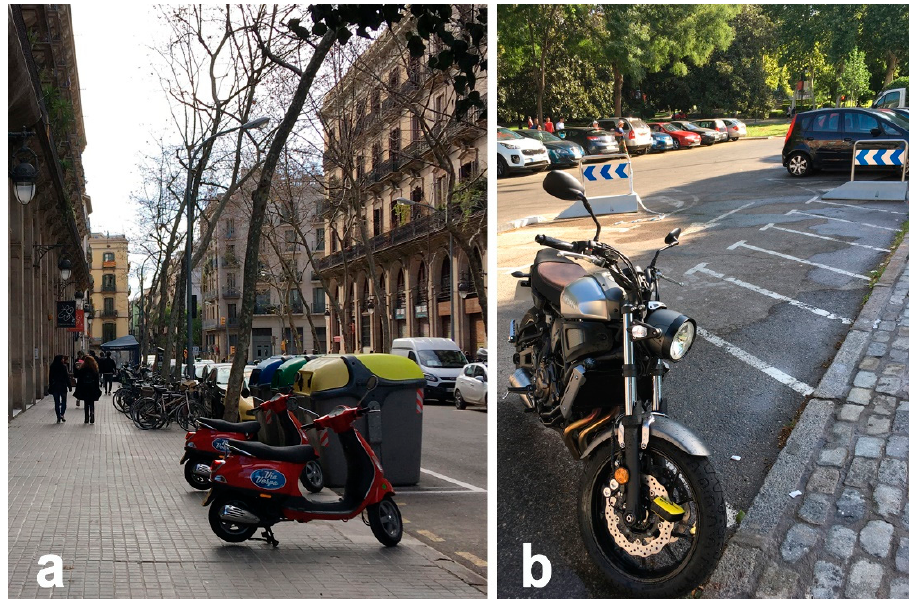
Figure 2. Basic parameters regarding the location of parking zones and parking of motorbikes and scooters in Barcelona (elaborated, based on Barcelona City Hall brochure: https://www.barce- lona.cat/mobilitat/sites/default/files/Proposta%20fullet%c3%b2%20FINAL.pdf; accessed on 9 Feb- ruary 2021).